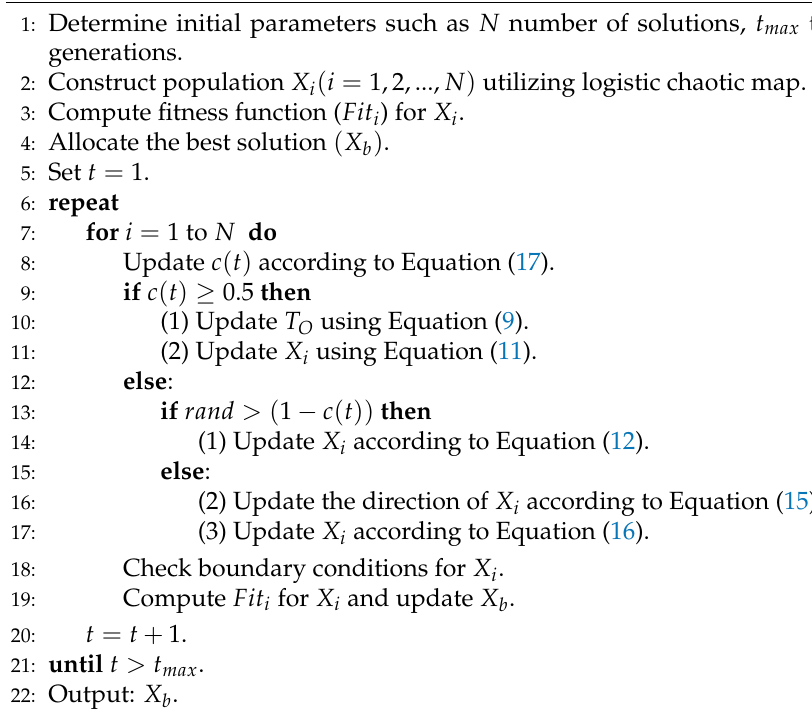
Algorithm 1 Steps of jellyfish optimization